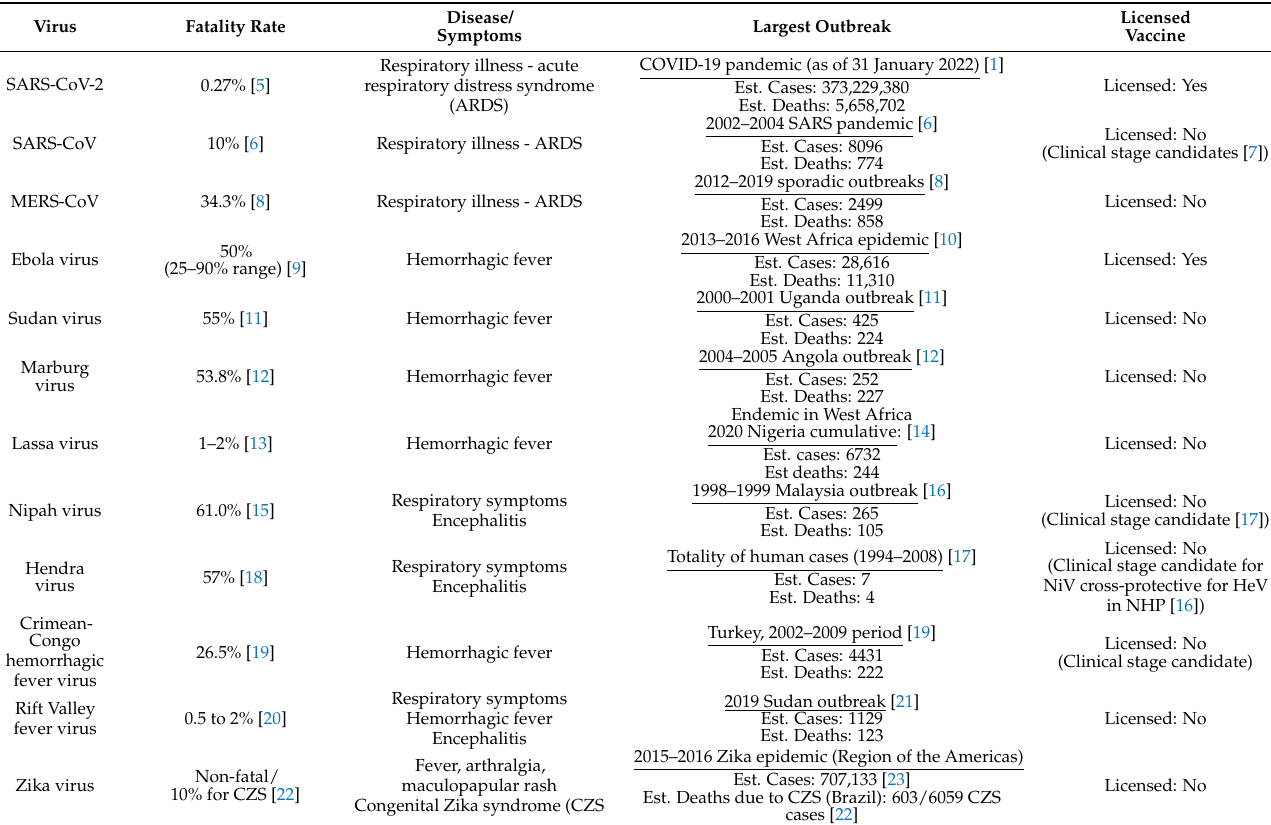
Table 1. Characteristics of select viruses of pandemic